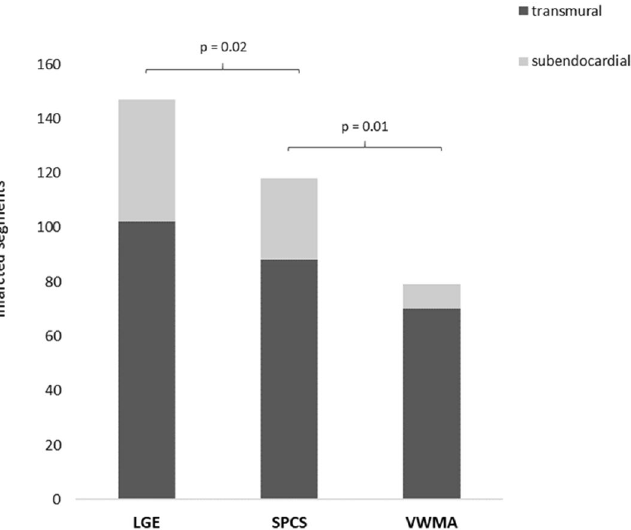
Figure 5. Localization of infarcted segments in segmental circumferential strain calculations (SPCS) showed significantly more infarcted segments (80.3%) than visual assessment of wall motion abnormalities in cine images (53.7%); infarcted segments in LGE images served as gold standard. Brackets signalize significance between groups. LGE late gadolinium enhancement, SPCS segmental peak circumferential strain, VWMA visual wall motion